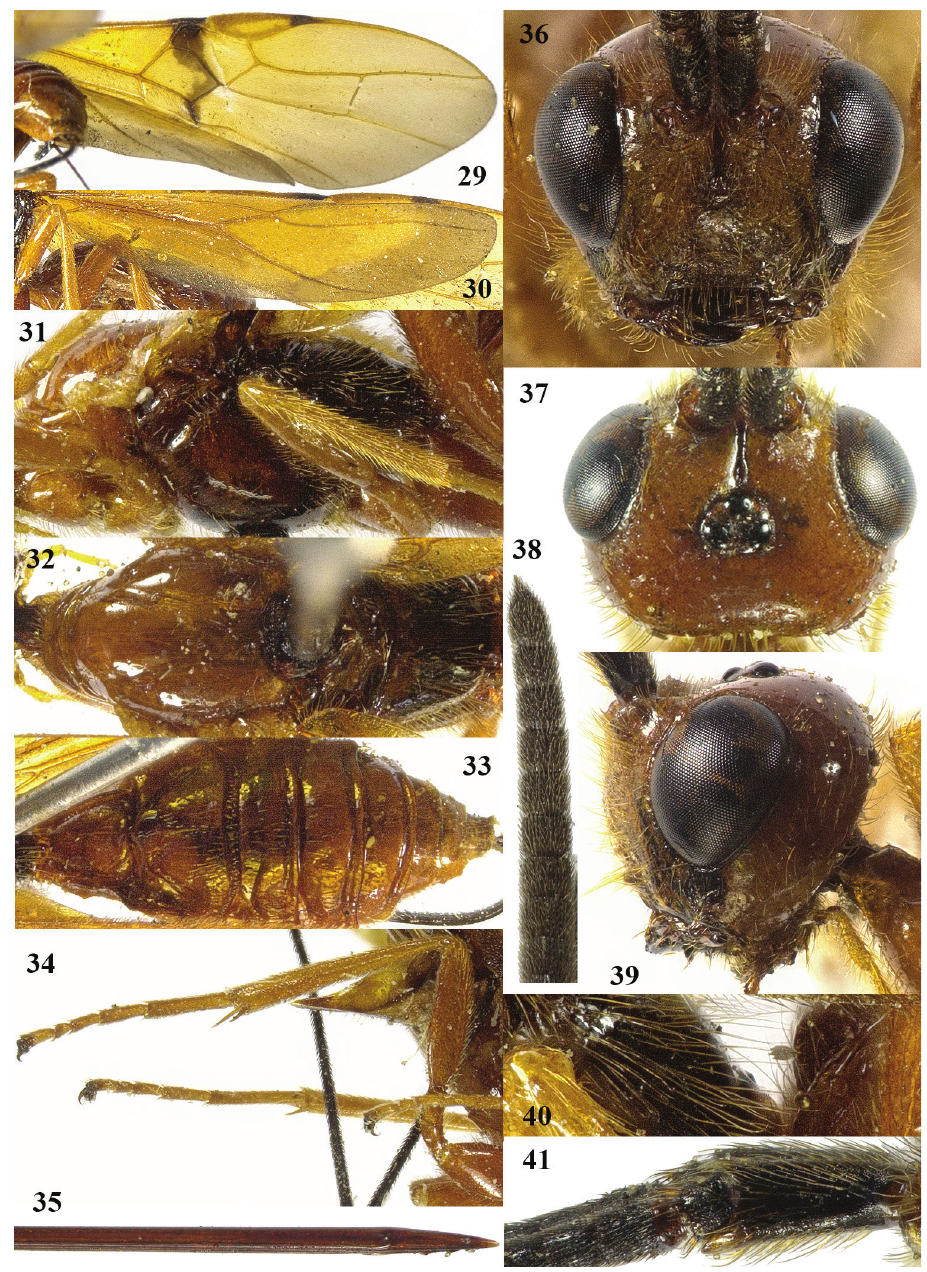
Figures 29–41. Craspedolcus politus sp. n., ♀ , holotype. 29 fore wing 30 hind wing 31 mesosoma lateral 32 mesosoma dorsal 33 metasoma dorsal 34 hind leg lateral 35 apex of ovipositor lateral 36 head anterior 37 head dorsal 38 apex of antenna 39 head dorsal 40 propodeum lateral 41 scapus outer side